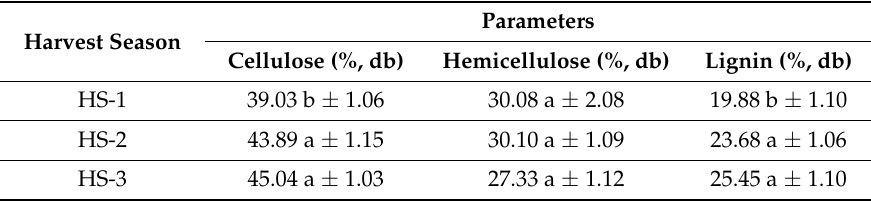
Table 4. Cell wall composition of Sida hermaphrodita